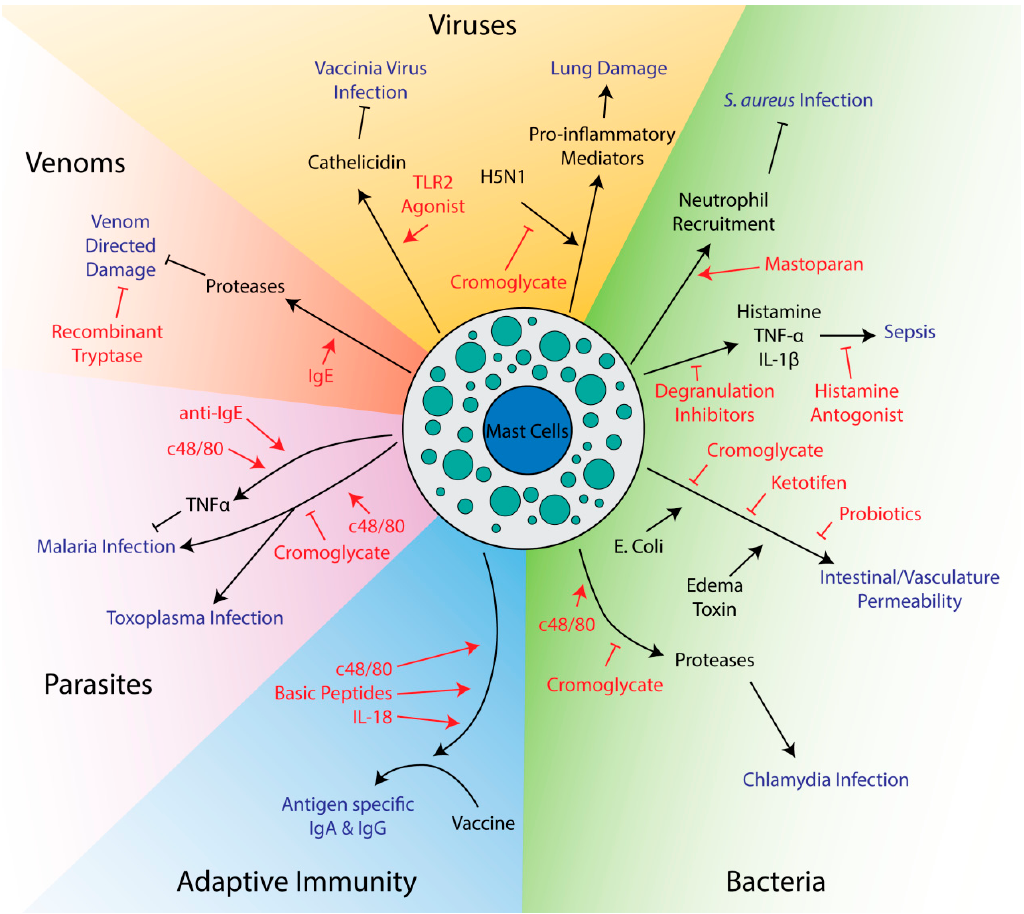
Figure 1. Potential therapeutics targeting mast cells in innate and adaptive immunity. Drugs and therapeutics are shown in red, while disease outcomes are shown in blue. Arrows indicate activation while flathead lines indicate inhibition.